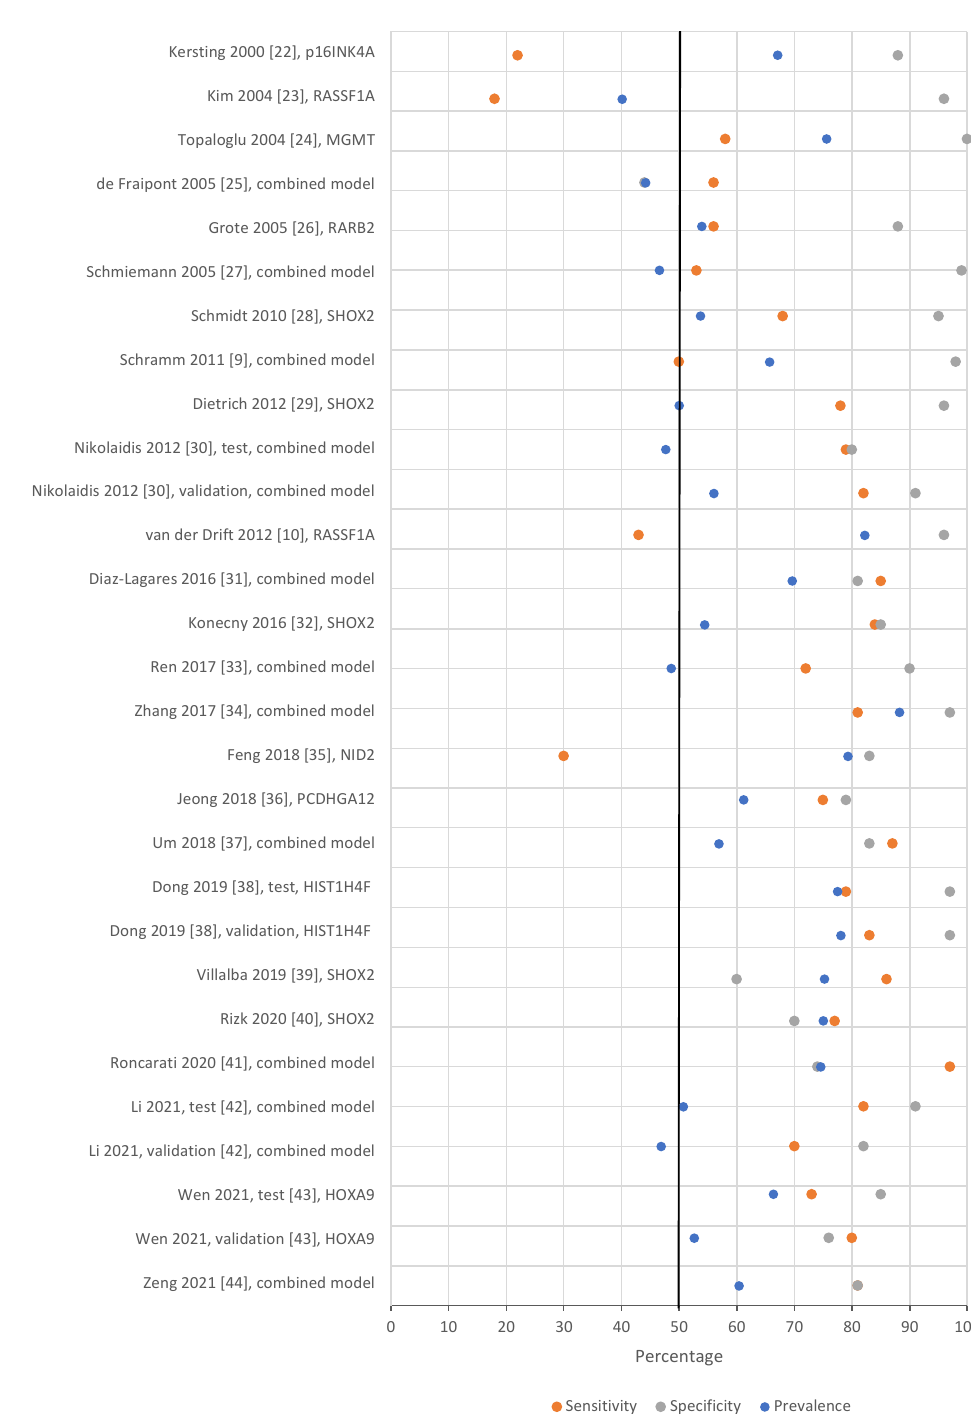
Figure 2. Forest plot of sensitivity (orange), specificity (gray), and prevalence of lung cancer (blue) for the combined biomarker panels or the best performing single gene from each included study. If a test and validation approach was used, both cohorts were included in the graph. The x-axis represents study sensitivity, specificity, and prevalence in percent. The vertical, black line represents the 50% mark. There are no whiskers, since many studies did not report a 95% confidence interval, standard error, or similar error margins.